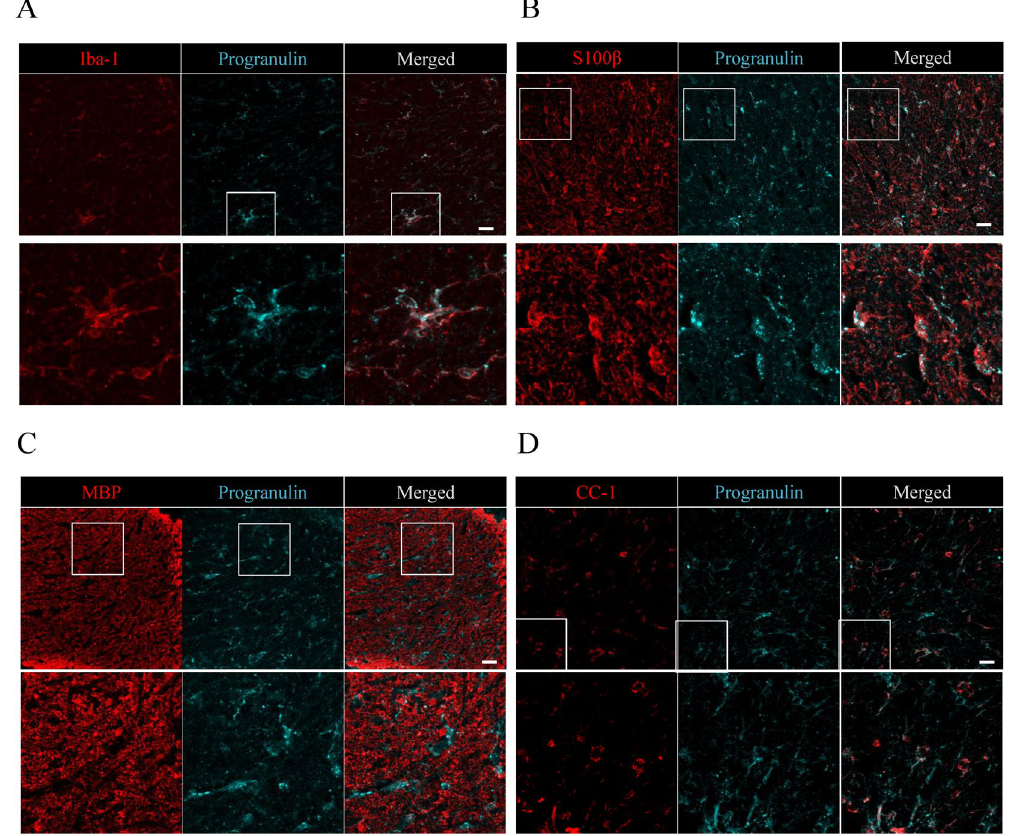
Figure 3. Progranulin expression in optic nerve. ( A ) Iba-1 + microglia (red) is co-localized with progranulin (cyan). ( B ) S100 β + astrocytes (red) are co-localized with progranulin. ( C , D ) Progranulin is partly co-localized with CC-1 + oligodendrocyte, but not with MBP. Scale bar = 20 μ